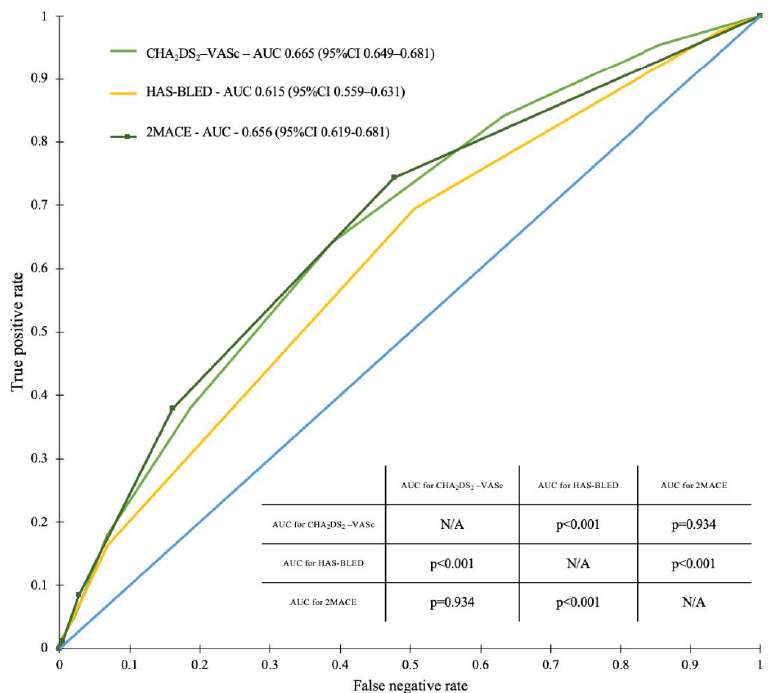
Figure 3. Receiver operating characteristic curves for the CHA 2 DS 2 -VASc, 2MACE, and HAS-BLED scores in predicting all-cause mortality in the overall study population. The inner table shows the p -values for comparisons between AUCs for the assessed scores. Abbreviations: AUC, area under the curve; CI, confidence interval; N/A, not applicable.